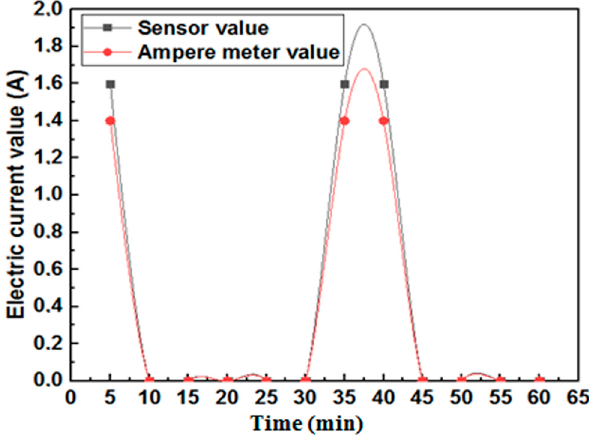
Figure 14. The outcome of measuring dispenser load.